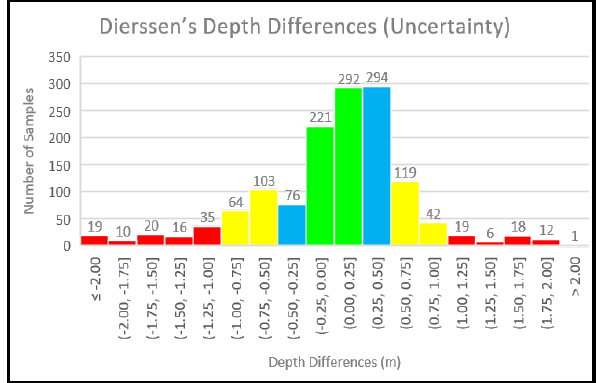
Figure 6. Distribution of depth differences and survey classes achievement from Dierssen’s model.